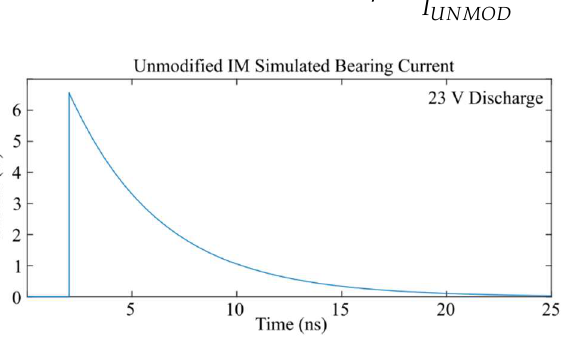
Figure 12. Simulated EDM bearing current for a 23 V shaft voltage discharge that dissipates in ~17